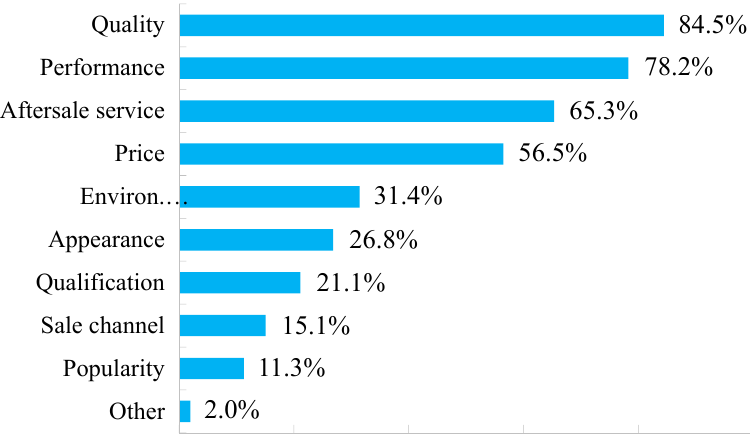
Figure 3. Pre-purchase considerations in purchasing remanufactured products.